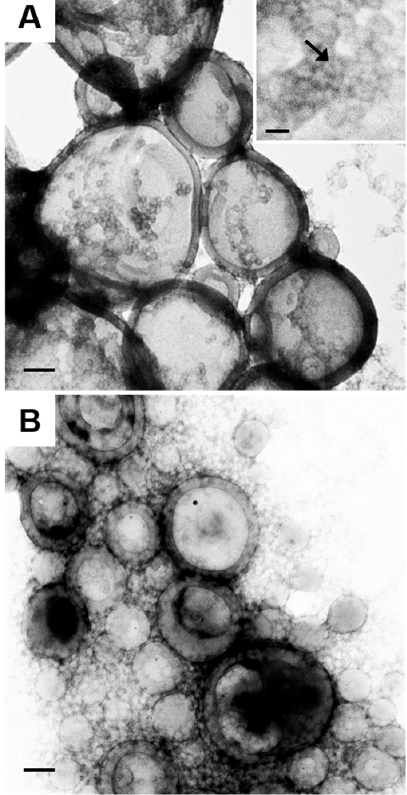
Figure 6. Low-magnification TEM images of QD-polymer vesicles formed from PS/PMAA-CdS in THF/water with c 0 = 0.25 wt % and ( A ) R NaCl = 1.5 and ( B ) R NaCl = 3.0. Inset to ( A ) shows core-shell nanoparticles that coexist with vesicles. All scale bars are 100 nm.